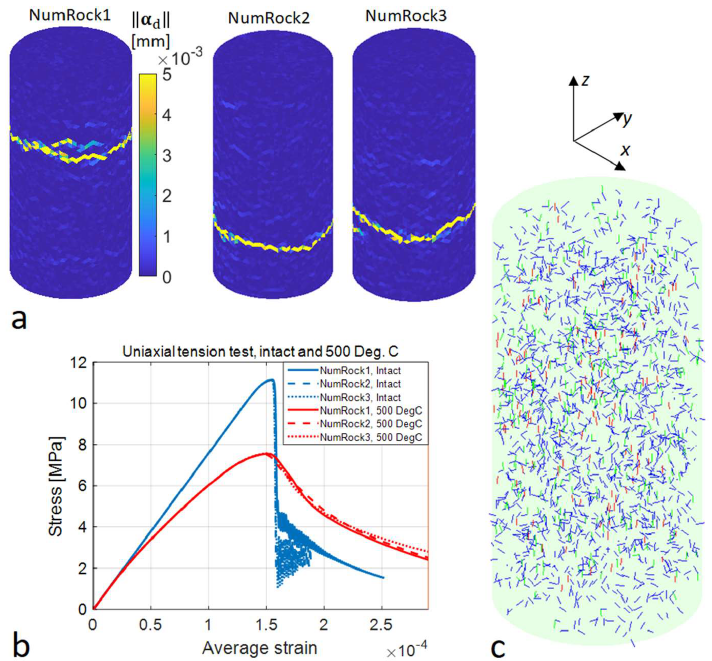
Figure 7. Simulation results for uniaxial tension test (heated 500 C): ( a ) Failure models represented by crack opening magnitudes; ( b ) Average stress-strain curves; ( c ) Crack normals for NumRock1 (blue = thermal cracks, red = tensile cracks, green = new tensile cracks in elements with a thermal crack).